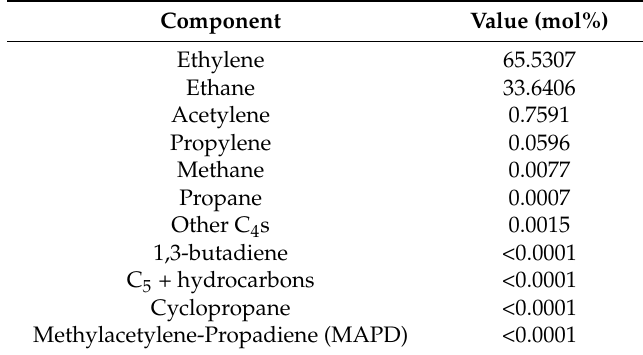
Table 4. Specification of inlet